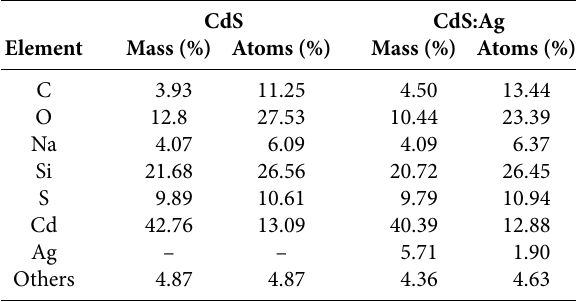
Table I. EDS measurements: mass and atomic